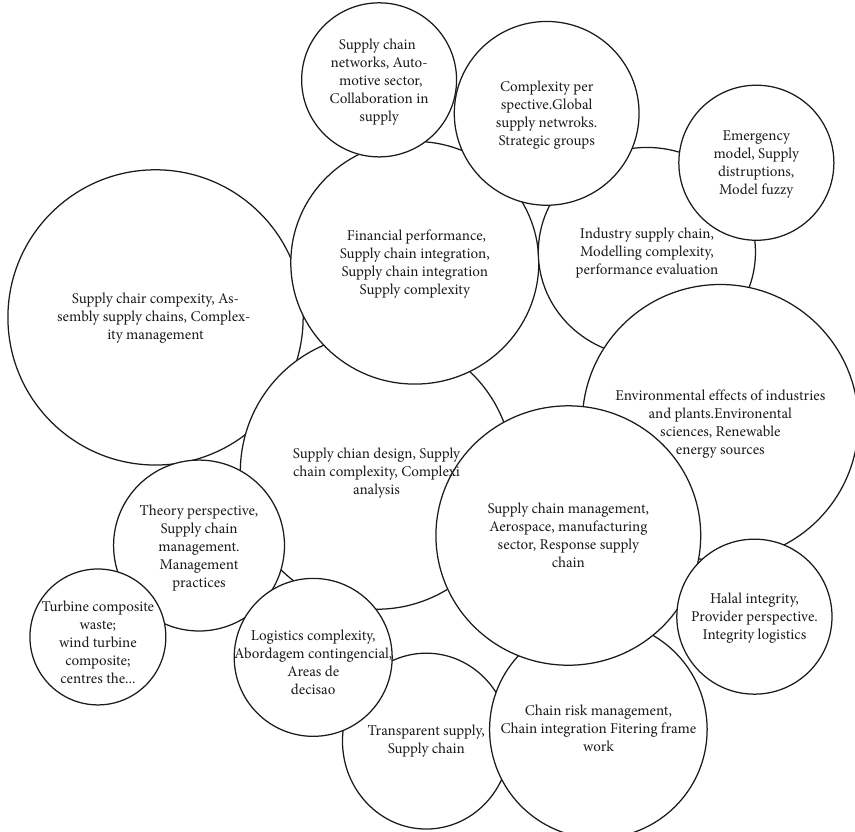
Figure 3: Overview of research on supply chain complexity. Source: Open Knowledge Maps (2022). Overview of research on supply chain complexity. Retrieved from https://openknowledgemaps.org/map/7ab5811ae0ec2eb91d0c795129953a82 (2 Mar